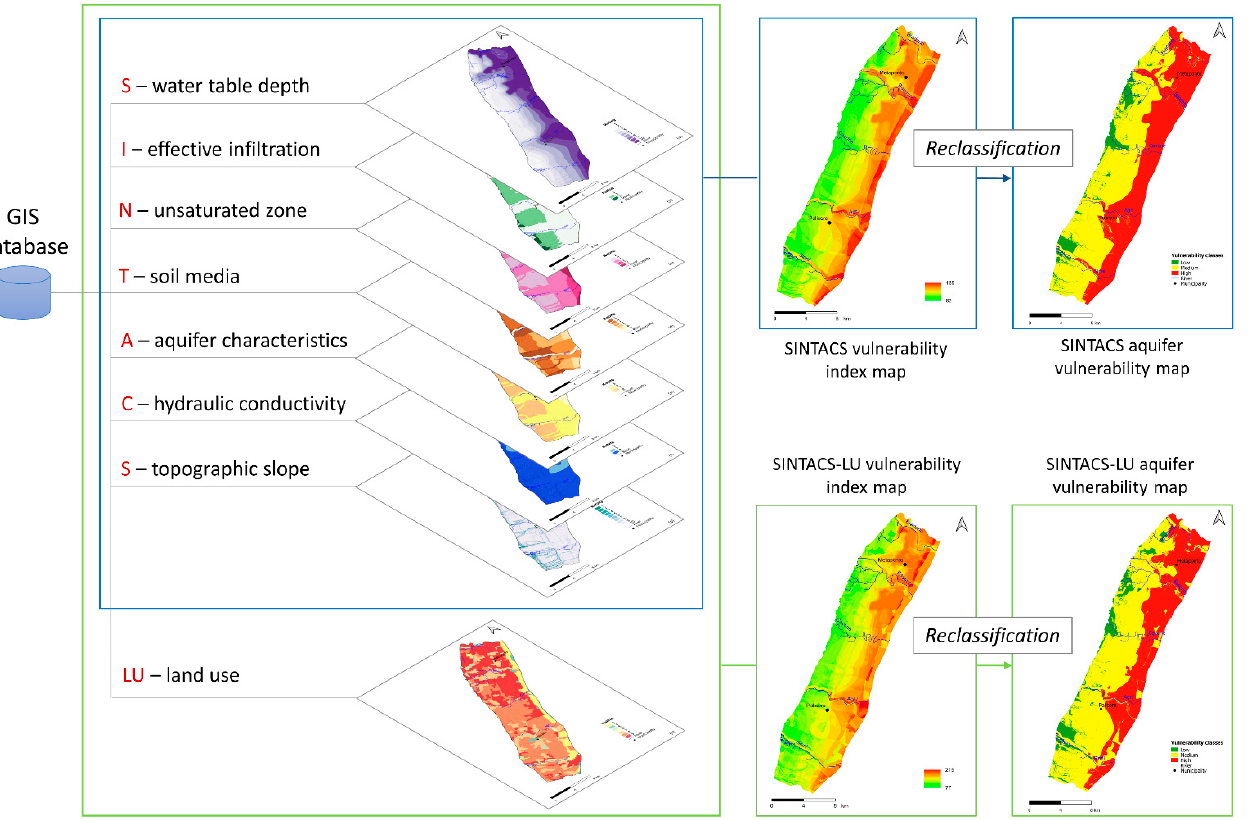
Figure 3. Methodology flow chart for SINTACS and SINTACS-LU methods.